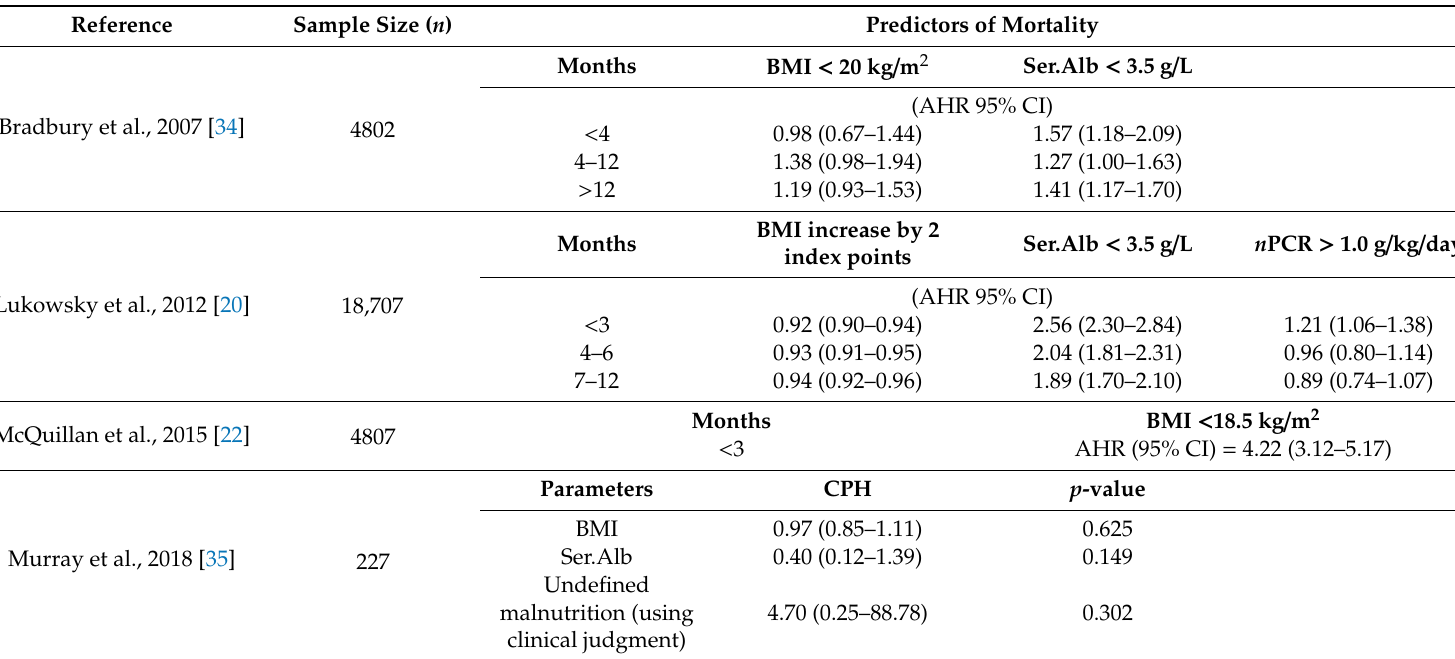
Table 1. Mortality risk within 12 months of HD initiation according to nutritional indicators of